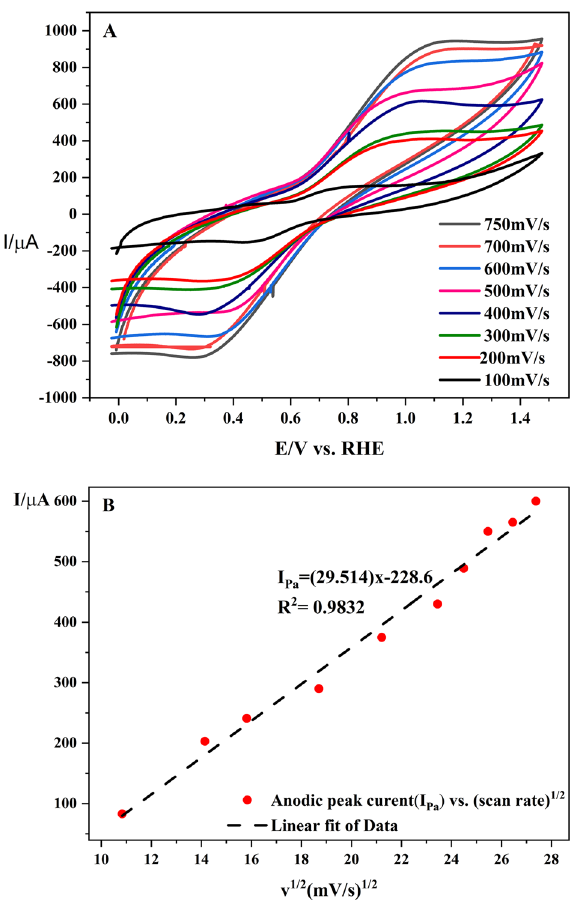
Figure 4. ( A ) CVs of 1 mM catechol obtained for the different scan rate analysis (100–750 mV/s) at the surface of Co-MOF/GCE in aqueous phosphate buffer solution (pH = 3); ( B ) The calibration plot of cathodic peak current versus square root of scan rates.